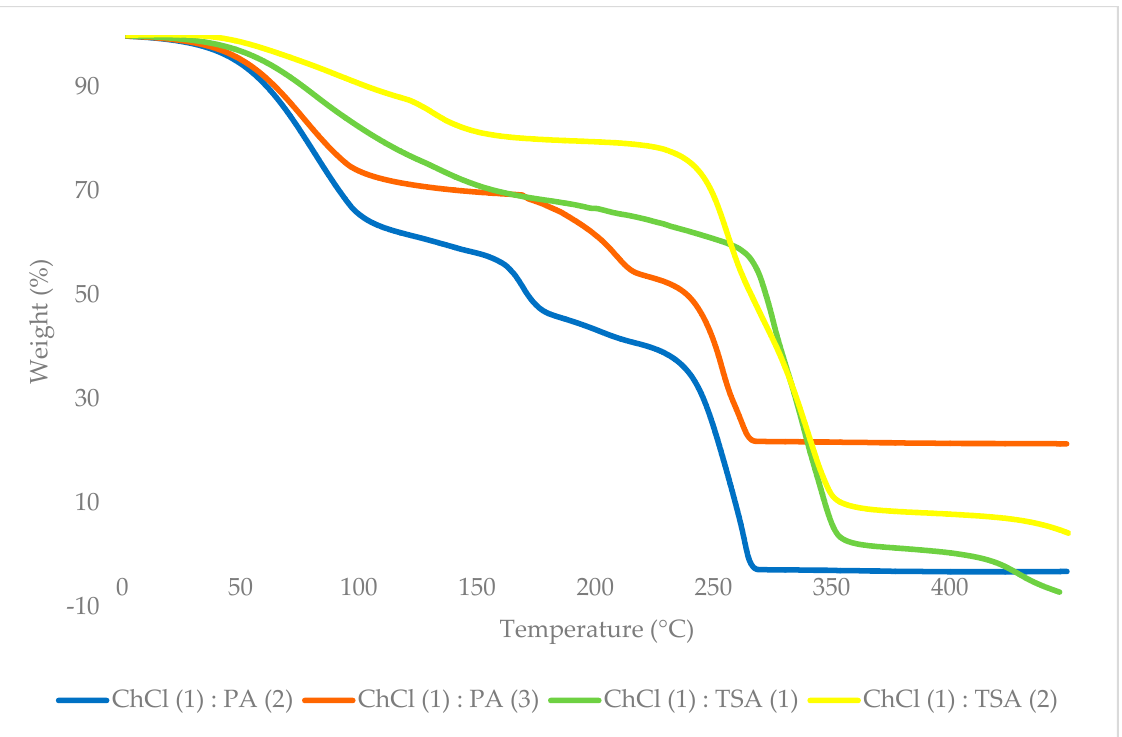
Figure 1. Weight content of EILs as a function of temperature for different types of acidic EILs.